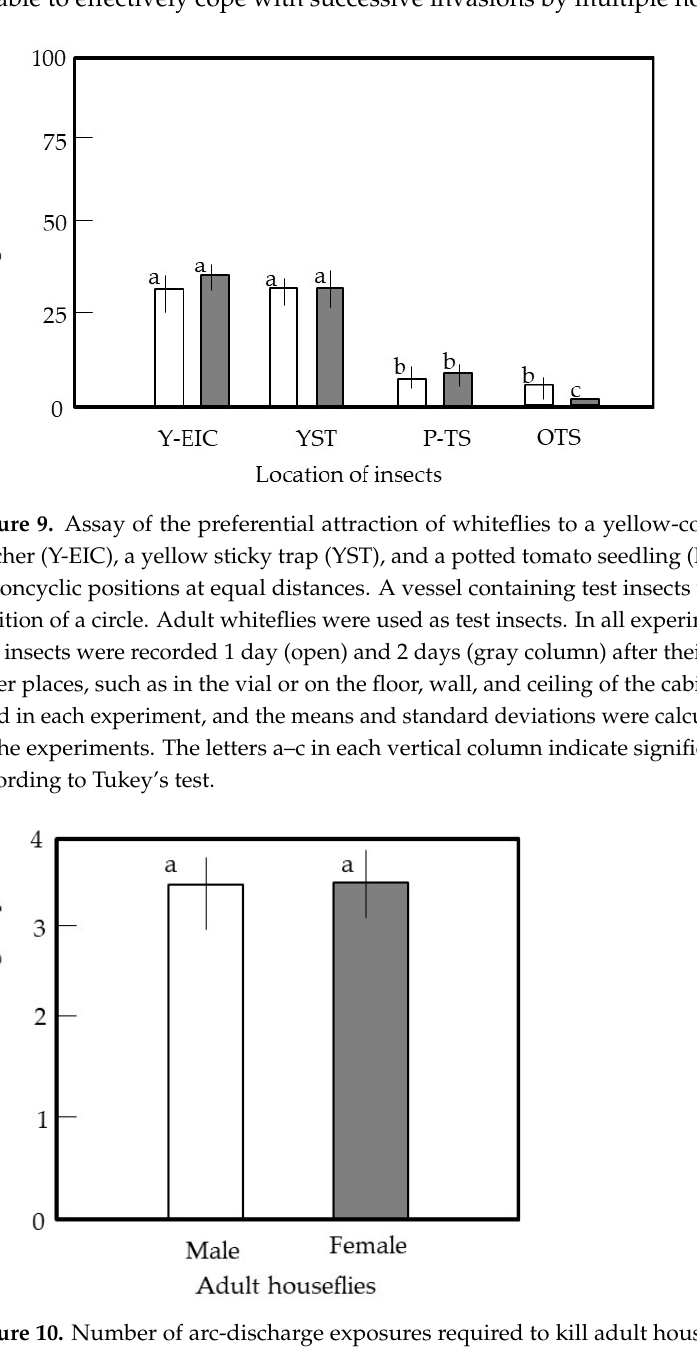
Figure 10. Number of arc-discharge exposures required to kill adult houseflies that climbed up to the arc discharge zapper (ADZ). The flies climbed along the wall of the cell of the grating placed beneath the ADZ and were subjected to the arc discharge when they reached the arcing zone of the device. They were knocked down to the bottom of the cell. The flies attempted several climbing trials and were exposed to repeated arc discharges until they died. Twenty insects were used in each experiment, and the means and standard deviations were calculated from five replicates of the experiments. The letter “a” in each vertical column indicates no significant difference ( p < 0.05) according to Tukey’s